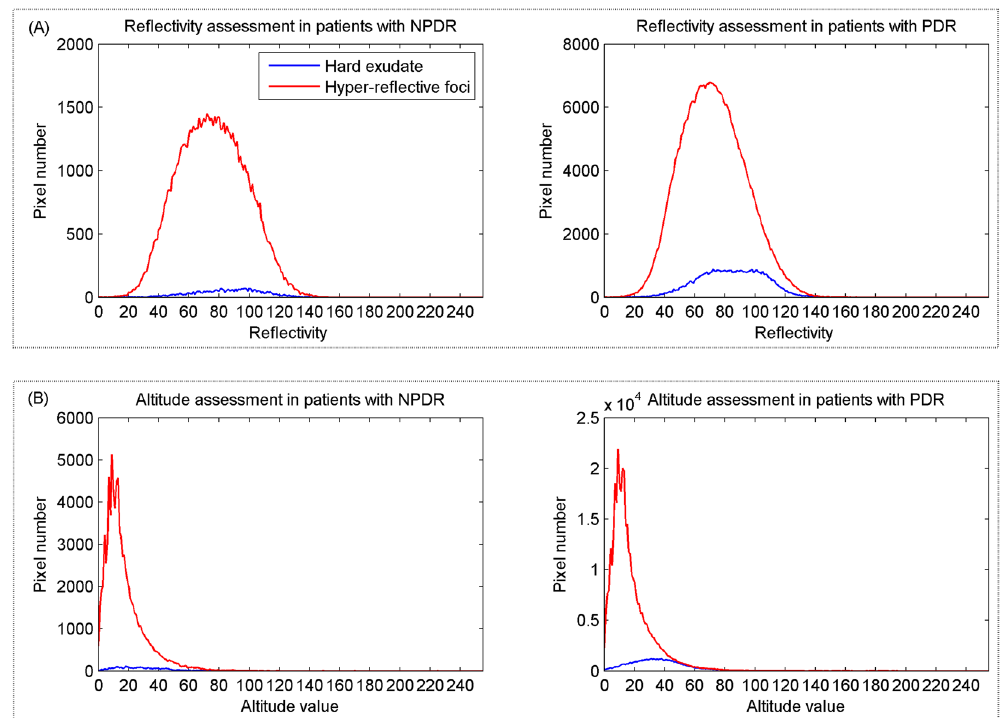
Figure 7. Results of the reflectivity and altitude distribution in SD OCT. ( A ) Reflectivity assessment of hyper- reflective foci and hard exudate in patients with NPDR and PDR. ( B ) Results of the altitude distribution of hyper-reflective foci and hard exudate in patients with NPDR and